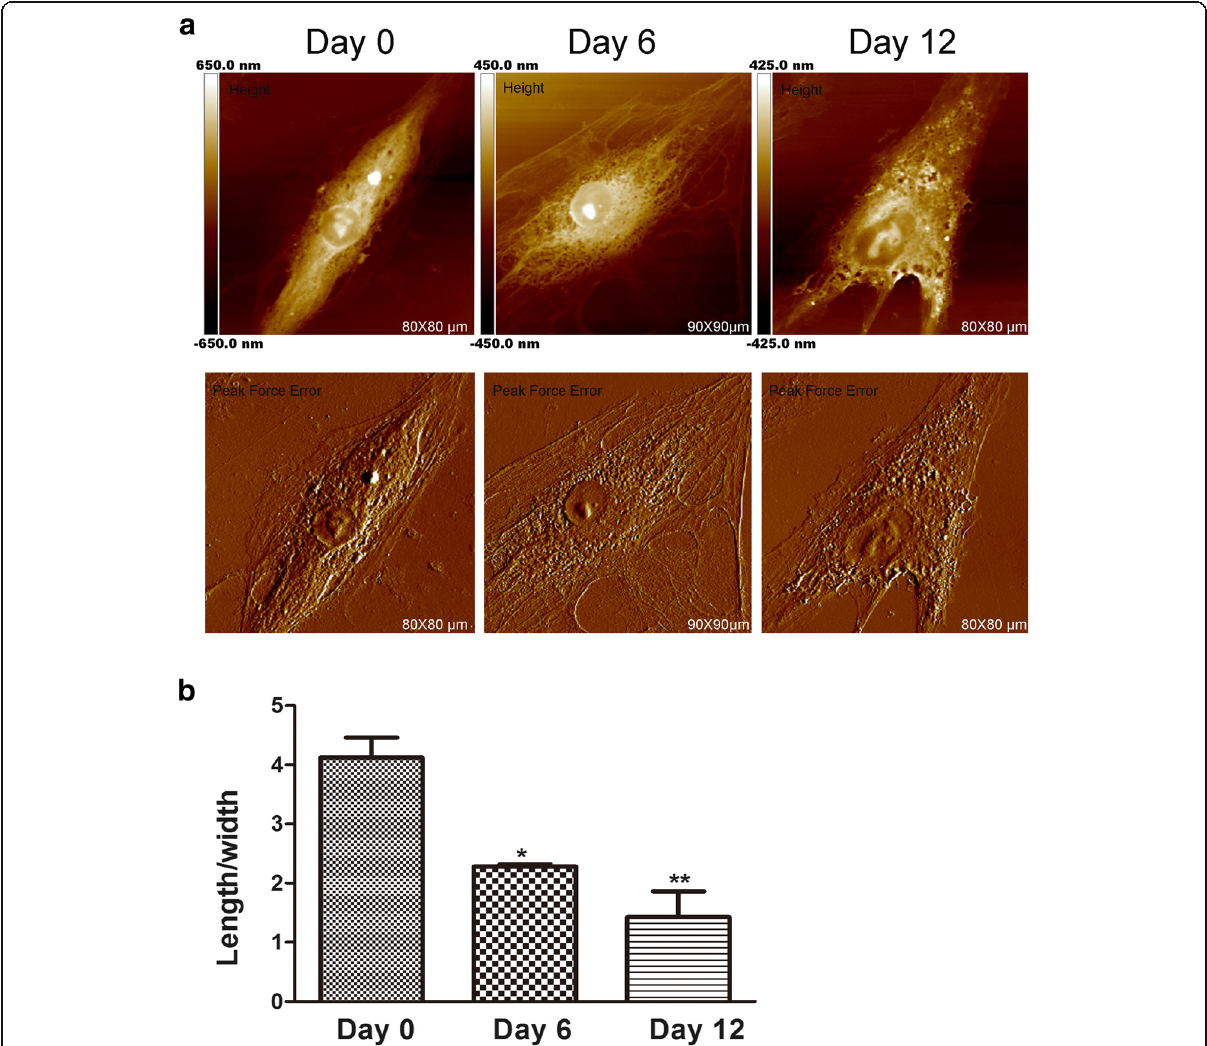
Fig. 1 Characteristics of hADSc morphology during chondrogenesis. a Morphological images of whole hADSc were obtained at 0, 6, and 12 days of chondrogenic differentiation. Images were analyzed by a Height and Peak Force Error Image Model by Nanoscope. b The average length/ width ratio of cells was measured following chondrogenic differentiation treatment at 0, 6, and 12 days. * p < 0.05, ** p <